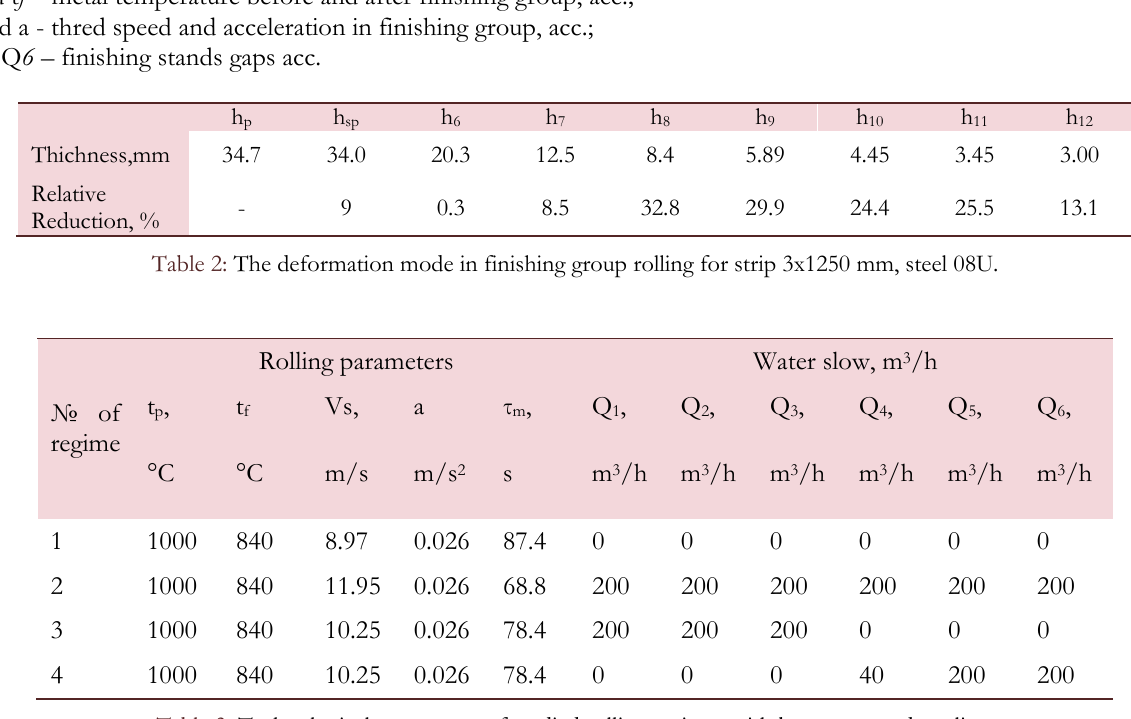
Table 3: Technological parameters of studied rolling regimes with between stand